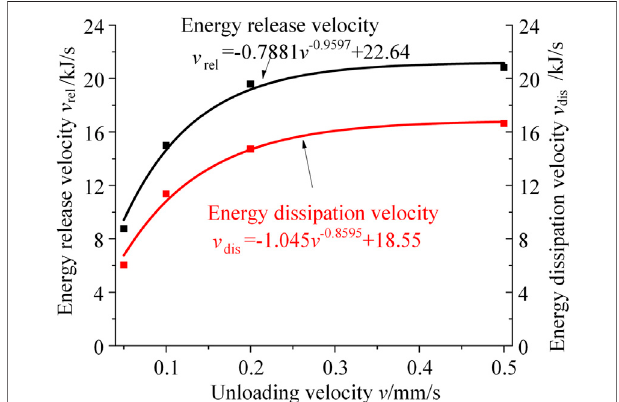
FIGURE 5 | Relationship between unloading velocity, energy release velocity, and energy dissipation velocity.